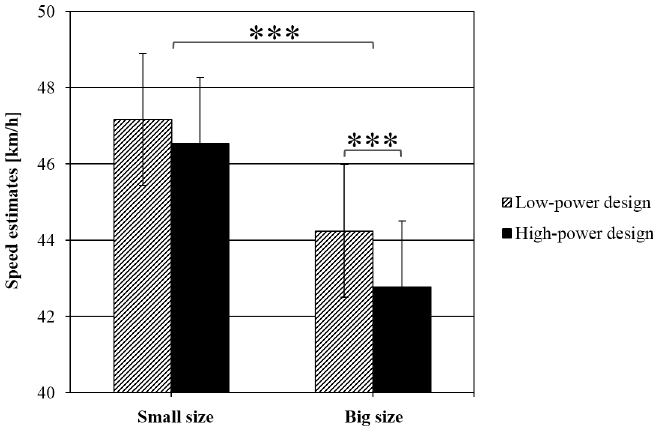
Fig 4. Speed estimations, depending on power and car size. Error bars represent standard errors.